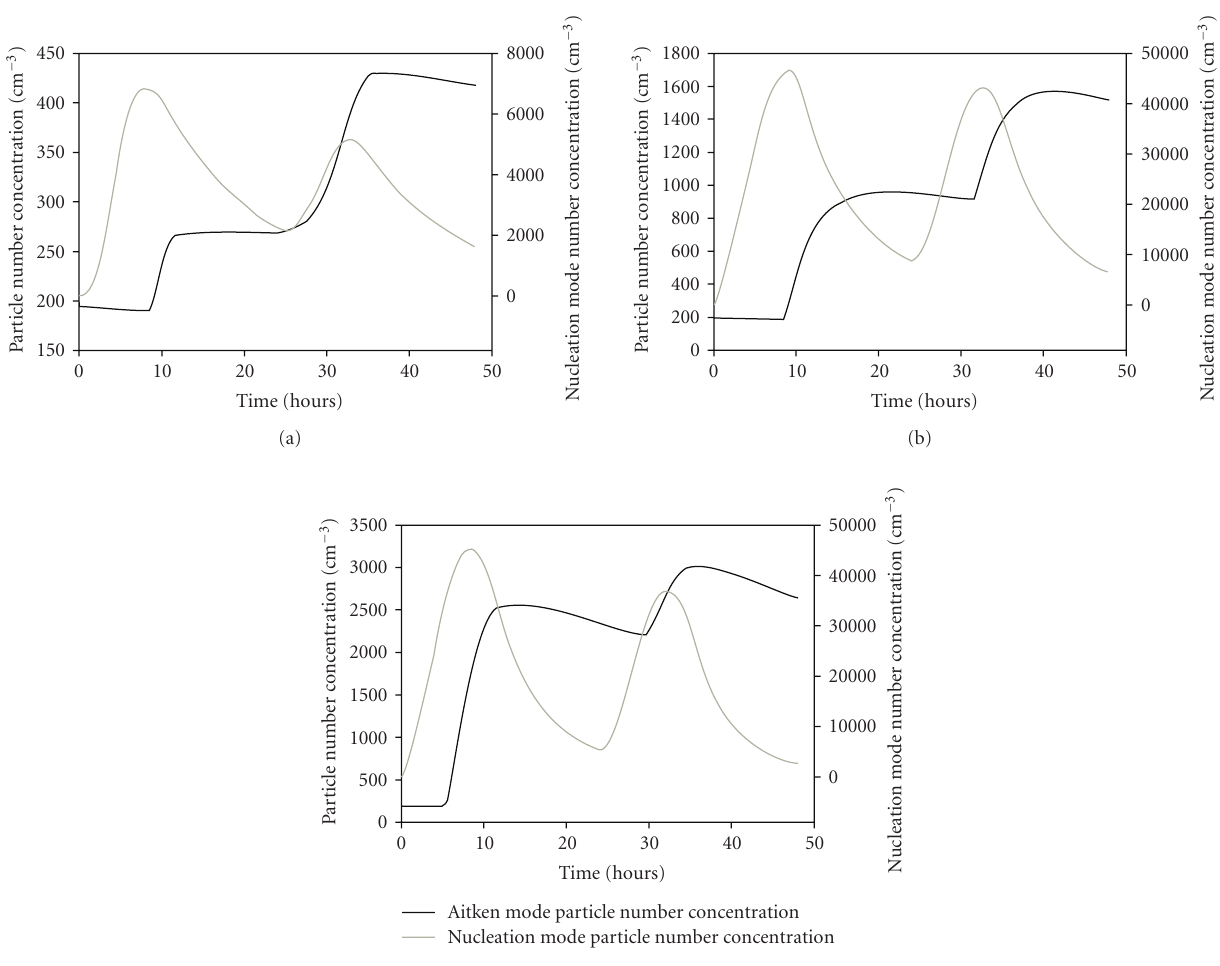
Figure 3: (a) Particle concentrations from the iodine oxide self-nucleation scheme taken over 48 hours at maximum OIO vapor concentrations of 6 × 10 6 molecules cm − 3 . (b) Particle concentrations from the sulfuric acid-iodine-driven nucleation schemes taken over 48 hours at maximum vapor concentrations of 6 × 10 6 molecules cm − 3 for both vapors. (c) Particle concentrations of sulfuric acid-iodine-based nucleation scheme in the presence of organic condensable vapor nucleation schemes taken over 48 hours at maximum vapor concentrations of 6 × 10 6 molecules cm − 3 for the sulphuric acid and iodine, along with a maximum of 12 × 10 6 molecules cm − 3 for the nonnucleating organic